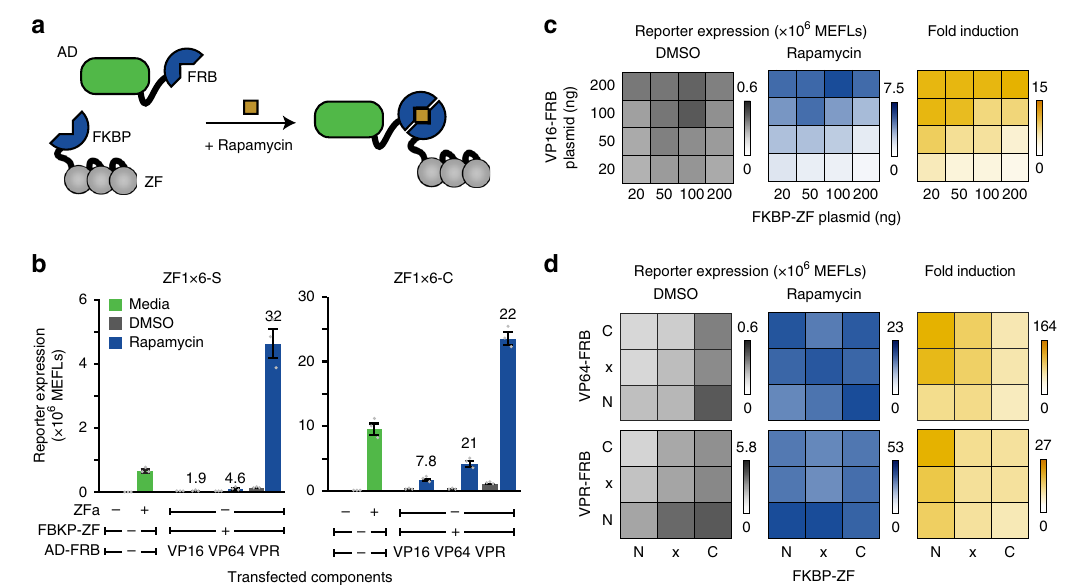
Fig. 7 Engineering small molecule-responsive TFs. a The cartoon illustrates chemically responsive control of gene expression using rapamycin-inducible ZFa (RaZFa). b The effects of promoter architecture and AD on RaZFa performance were evaluated. For all RaZFa on both promoters, reporter expression was signi fi cantly higher with rapamycin than DMSO (one-tailed Welch ’ s t- test, all p < 0.05). Fold induction is shown above the rapamycin case for relevant conditions. c Gene expression in the absence of rapamycin was affected by VP16-FRB dose (two-factor ANOVA p < 0.001) and FKBP-ZF dose ( p < 0.001), with no interaction between these variables ( p = 0.14). Reporter expression after rapamycin addition was affected by VP16-FRB dose (two-factor ANOVA p < 0.001) and FKBP-ZF dose ( p < 0.001) with a signi fi cant interaction between these variables ( p < 0.001). d Effects of subcellular localization tags: N = nuclear, x = no localization, C = cytoplasmic. For VP64-based RaZFa, gene expression in the absence of rapamycin was affected by AD-FRB localization (two-factor ANOVA p = 0.01) and FKBP-ZF localization ( p < 0.001), with no interaction between these variables ( p = 0.39). For VP64-based RaZFa, gene expression after rapamycin addition was not affected by AD-FRB localization (two-factor ANOVA p = 0.26) but was affected by FKBP-ZF localization ( p = 0.02), with an interaction ( p = 0.001). For VPR-based RaZFa, gene expression in the absence of rapamycin was affected by AD-FRB localization (two- factor ANOVA p < 0.001) and FKBP-ZF localization ( p < 0.001), with an interaction ( p = 0.03). For VPR-based RaZFa, gene expression in the presence of rapamycin was affected by AD-FRB localization (two-factor ANOVA p < 0.001) but not by FKBP-ZF localization ( p = 0.29), with no interaction ( p > 0.05). Experiments in ( c , d ) use a ZF1x6-C promoter. Experiments were conducted in biologic triplicate, and data were analyzed as described in Methods. Error bars represent the S.E.M. Source data are provided in the Source Data fi